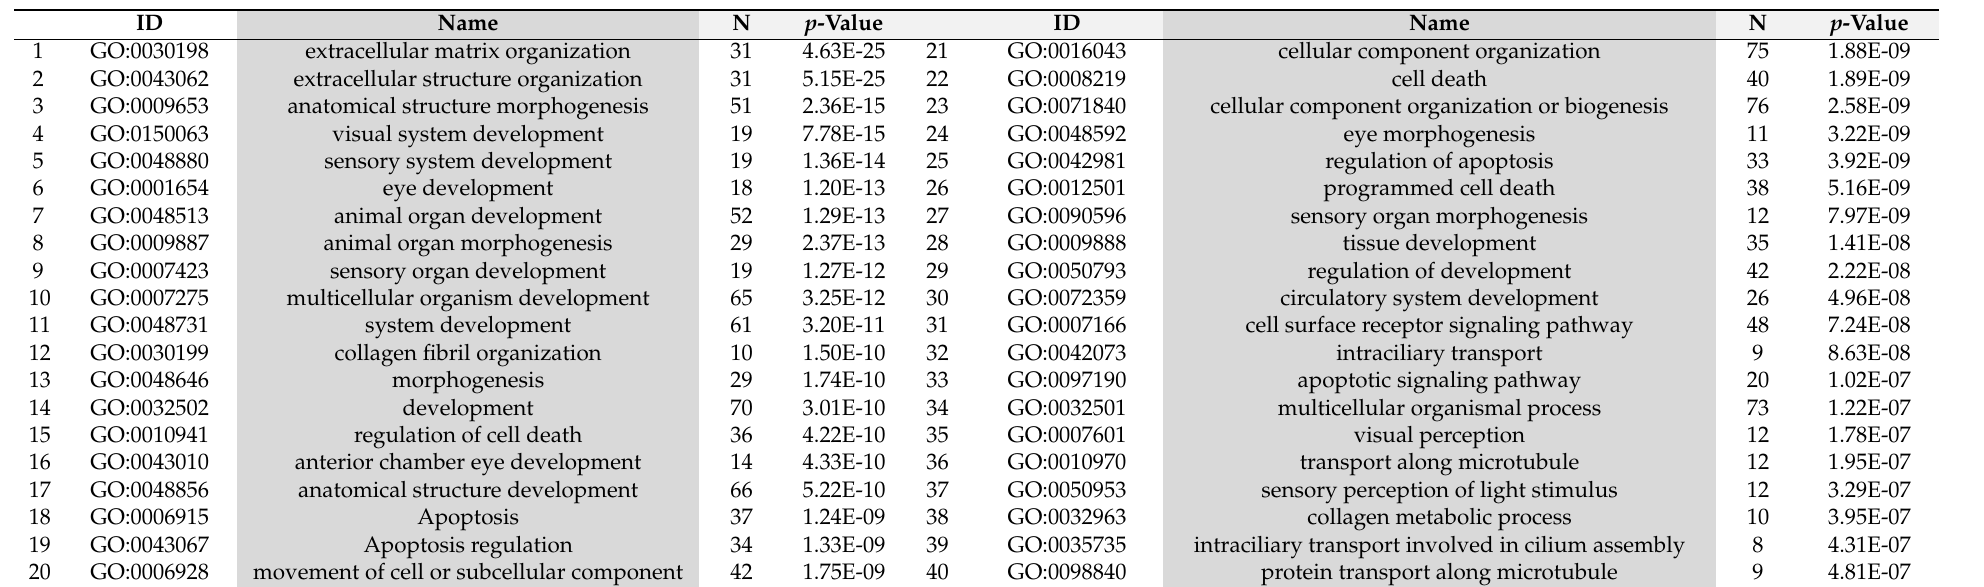
Table 7. Top 40 GO Biological Processes associated to POAG and with target